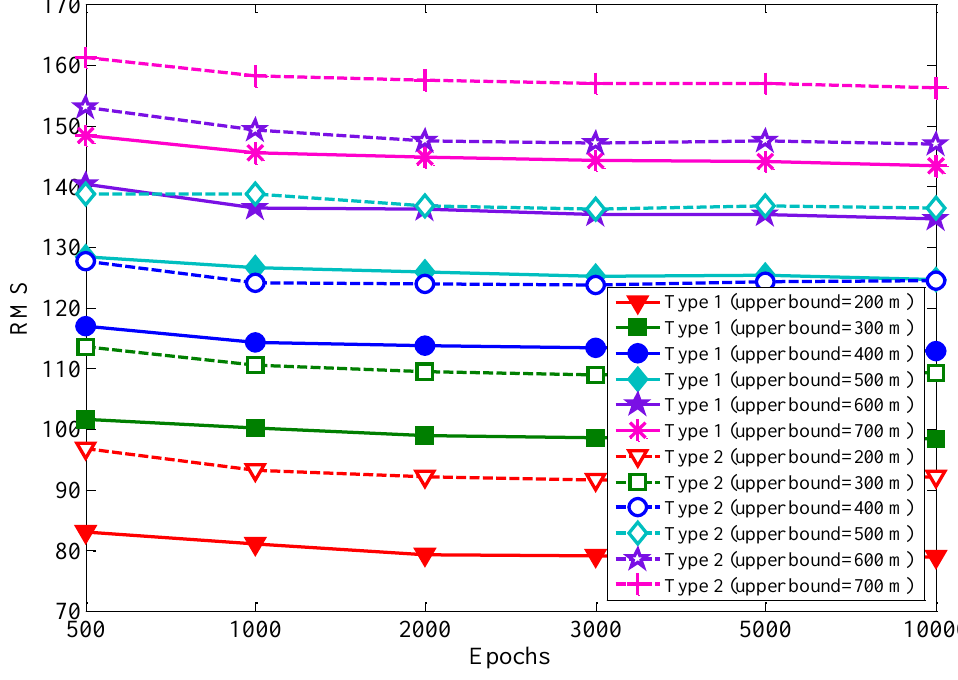
Figure 5. RMS errors reduction according to the number of epochs.